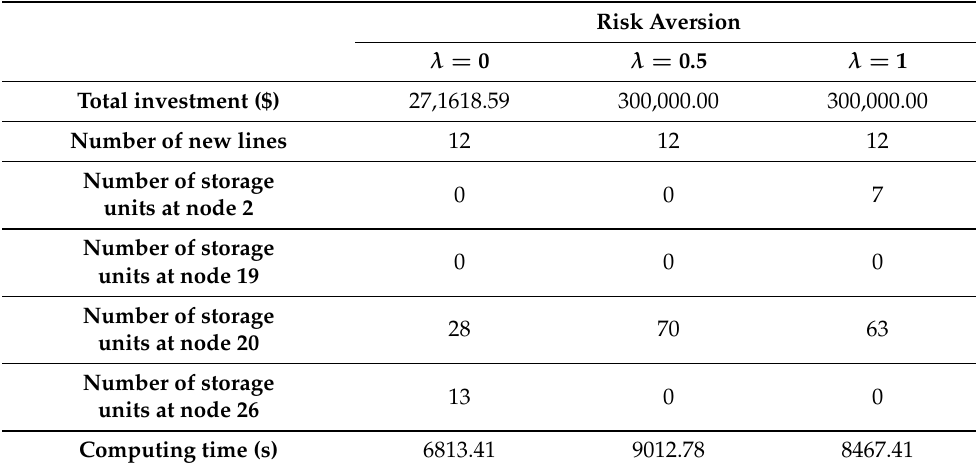
Table 4. Obtained expansion plans under investment budget